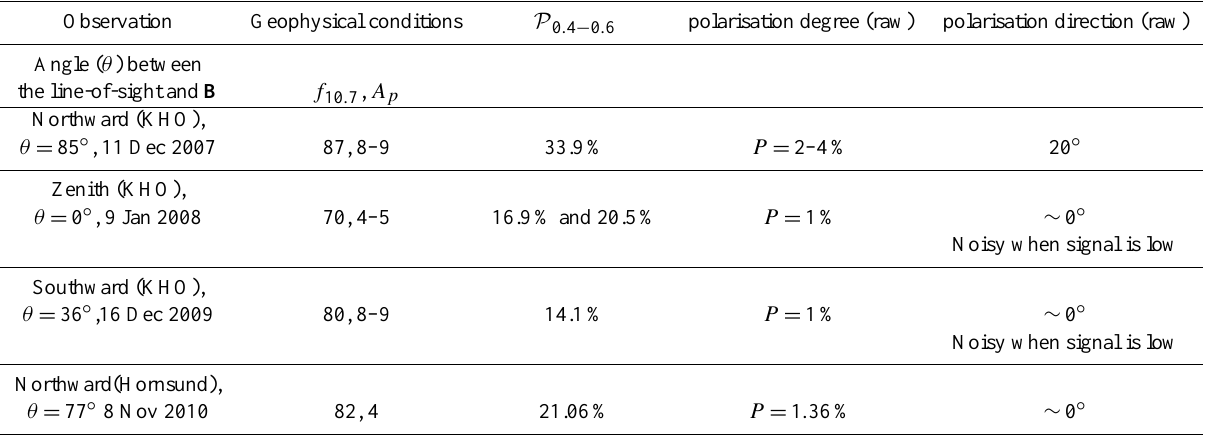
Noisy when signal is low